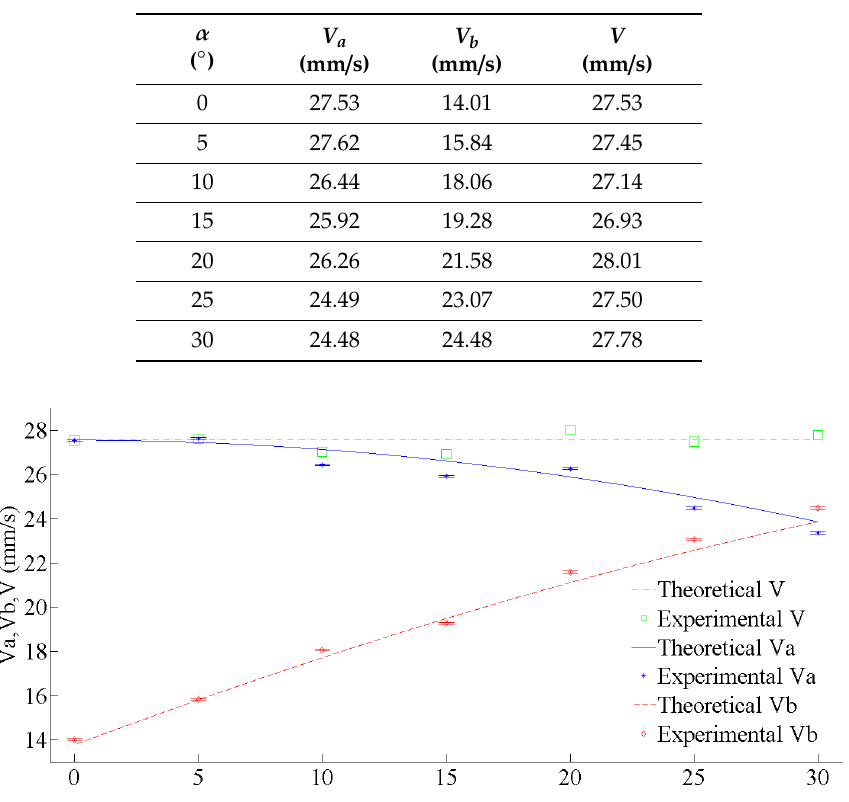
Figure 7. Measured particle velocity versus moving direction α .